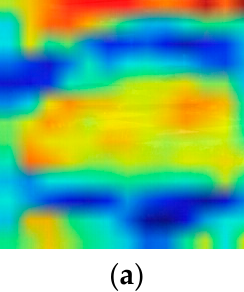
Figure 9. Multi-scale feature heat map: ( a ) 8 × 8 feature maps; ( b ) 16 × 16 feature maps; ( c ) 32 × 32 features. It can be seen that large scale feature maps are sensitive to small targets, while small scale feature maps are effective for large-sized objects such as backgrounds.